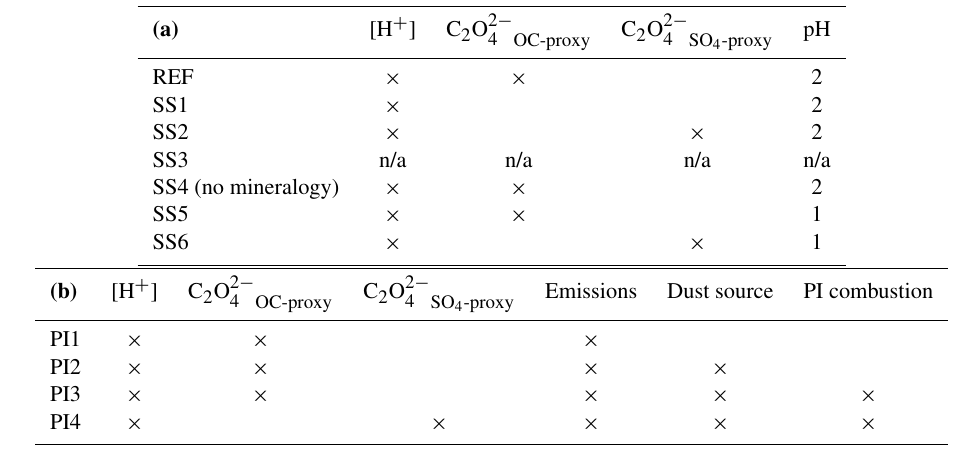
Table 1. (a) List of current climate simulation used in this study. [H + ] indicates proton-promoted aerosol water iron processing. C 2 O 2 − is the parameterization for in-cloud iron processing including the oxalate parameterization derived from model concentra- 4 OC-proxy tions of organic carbon and secondary organic carbon. C 2 O 2 − calculates oxalate concentration from model sulfate concentrations. 4 SO 4 -proxy SS4 tracers have no spatial dependence on mineralogy and have prescribed global average fractions from the reference case (REF) at emis- sion. (b) List of preindustrial simulations used in this study. Preindustrial simulations assume pH = 2 when model concentrations of sulfate are greater than